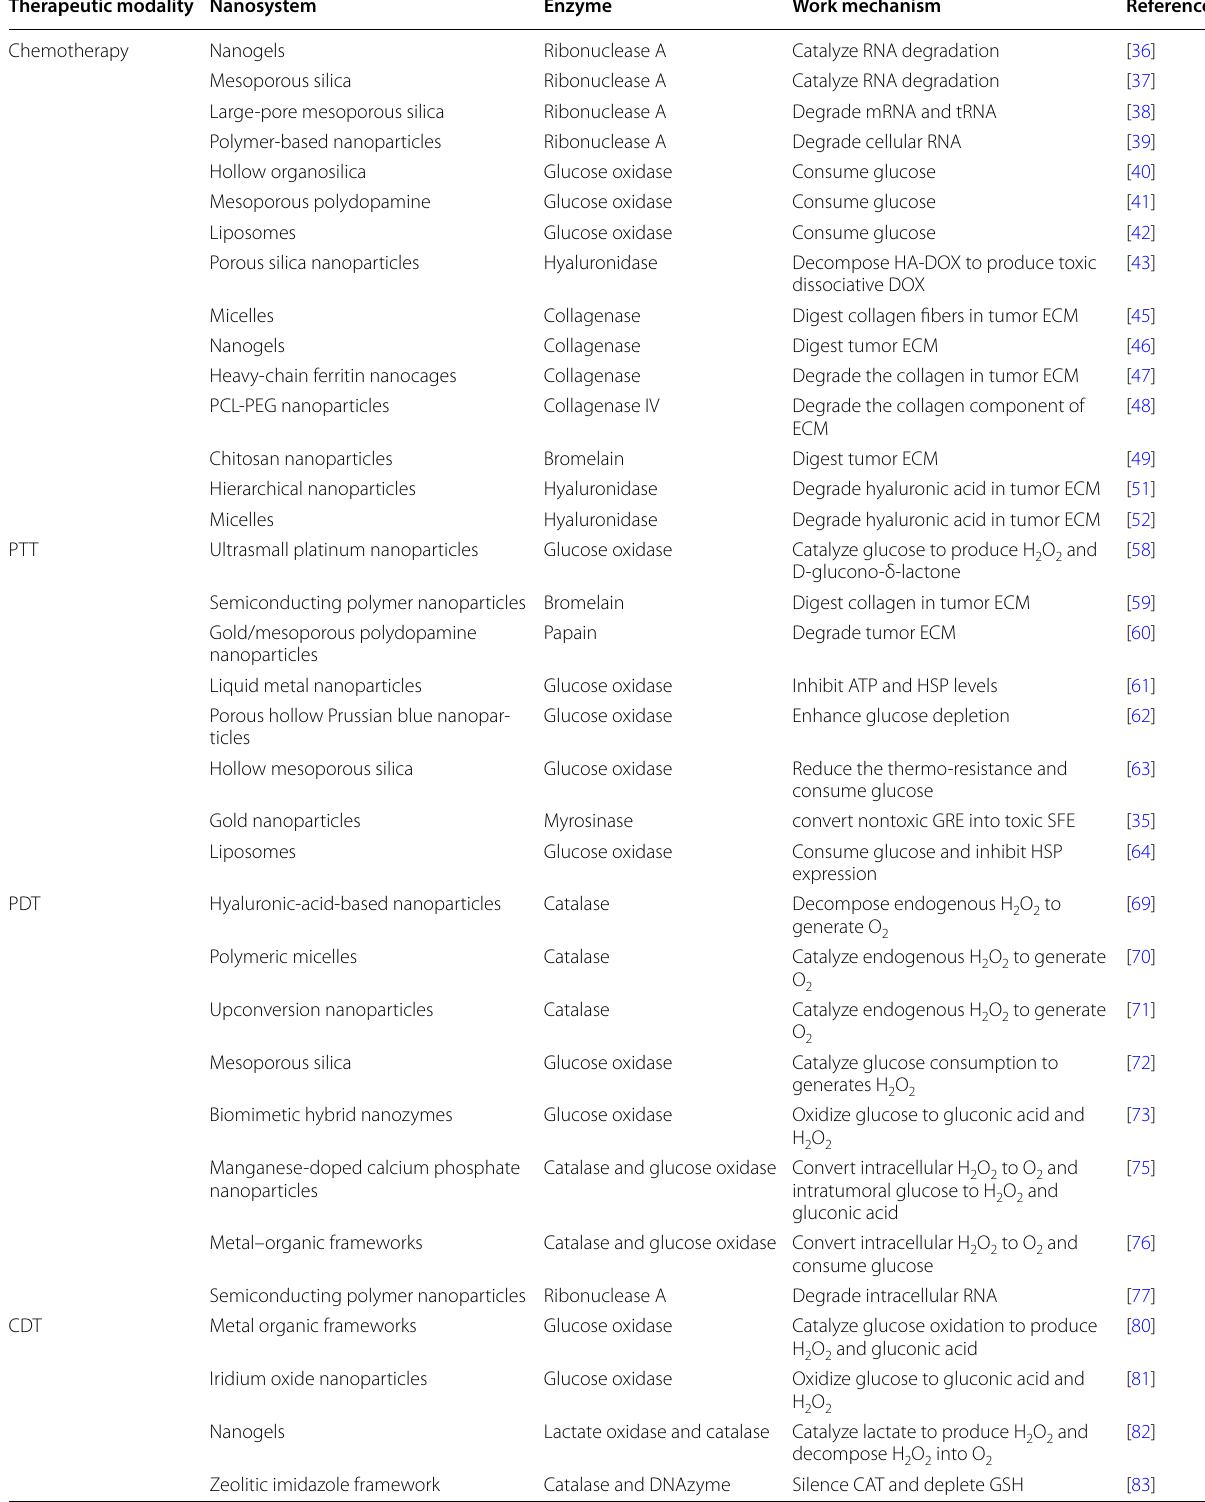
Table 1 Summary of bioenzyme-based nanomedicines for enhanced cancer therapy Therapeutic modality Nanosystem